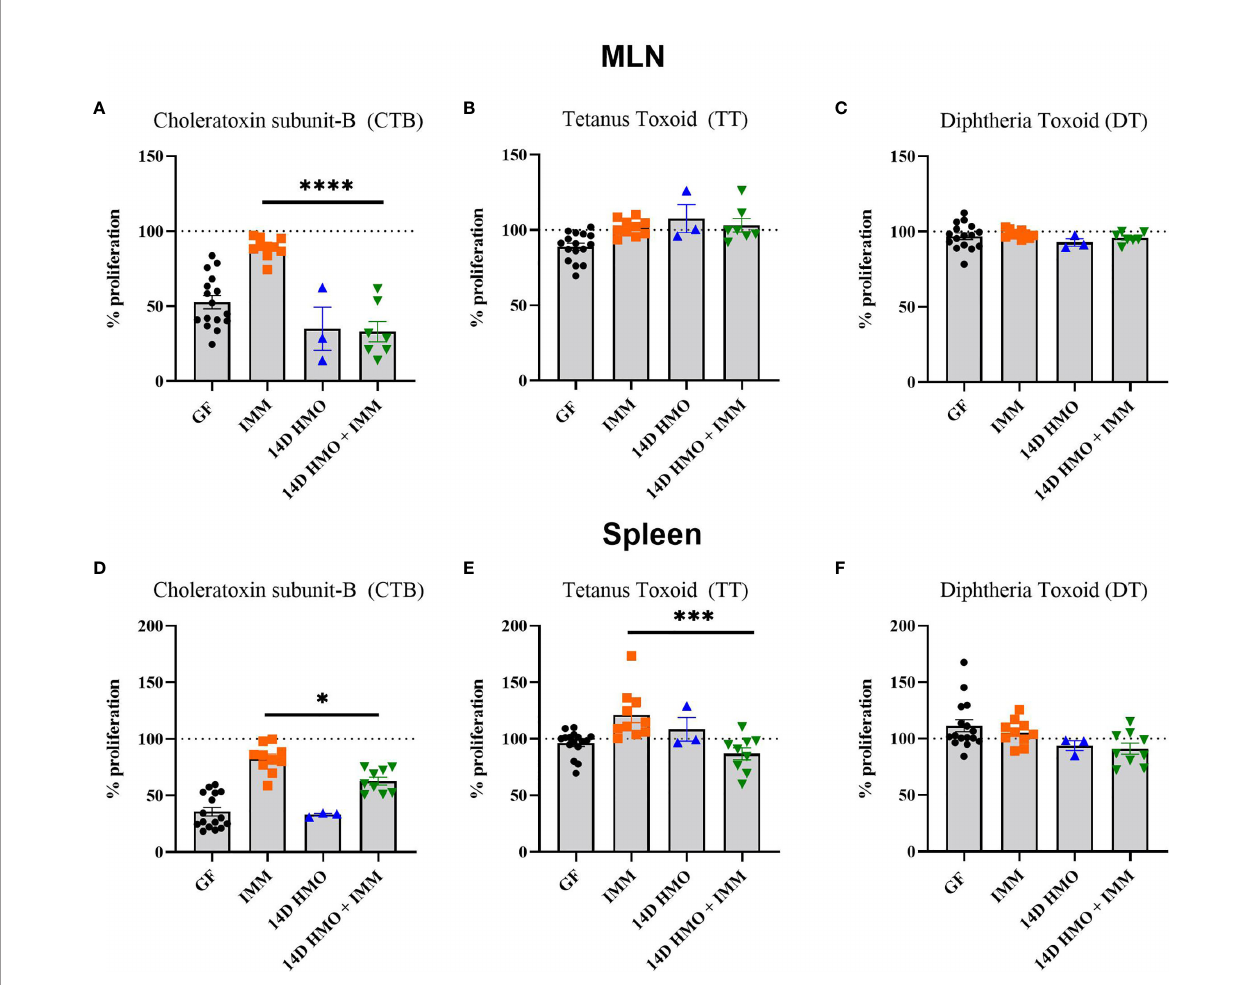
FIGURE 11 | The proliferation response elicited from MLN or spleen cells to CTB, TT, or DT. (A – C) CT-, TT-, and DT-speci fi c proliferation in MLN, respectively. (D – F) CT-, TT-, and DT-speci fi c proliferation in spleen, respectively. Statistical signi fi cance between control and treatment groups were determined using one-way ANOVA with Bonferroni ’ s multiple comparison correction in GraphPad Prism Version 9.3.1 and the adjusted p- value <0.05 was considered signi fi cant. Outliers were removed using ROUT (Q = 1%) in GraphPad Prism Version 9.3.1. This indicates statistical signi fi cance.* P < 0.05, *** P < 0.005, ****P <